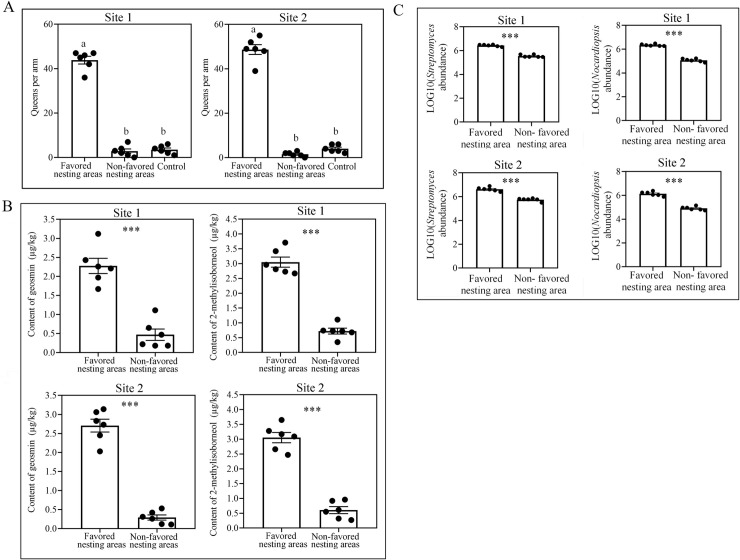
Data from more wild sites confirmed the association between S. invicta queen nesting preference and actinobacteria.(A) Choices of queens in regard to soil in olfactometer bioassays (±SE, n = 6 biological replicates). Control: empty arm. (B) Content of geosmin and 2-methylisoborneol (±SE, n = 6 biological replicates, independent sample t test). (C) Absolute abundance of Streptomyces and Nocardiopsis in soil achieved by qPCR (±SE, n = 6 biological replicates, independent sample t test). Different letters above bars indicate significant differences according to Kendall’s W test at the 0.05 level. Asterisks indicate significant differences (*P < 0.05, ***P < 0.001).